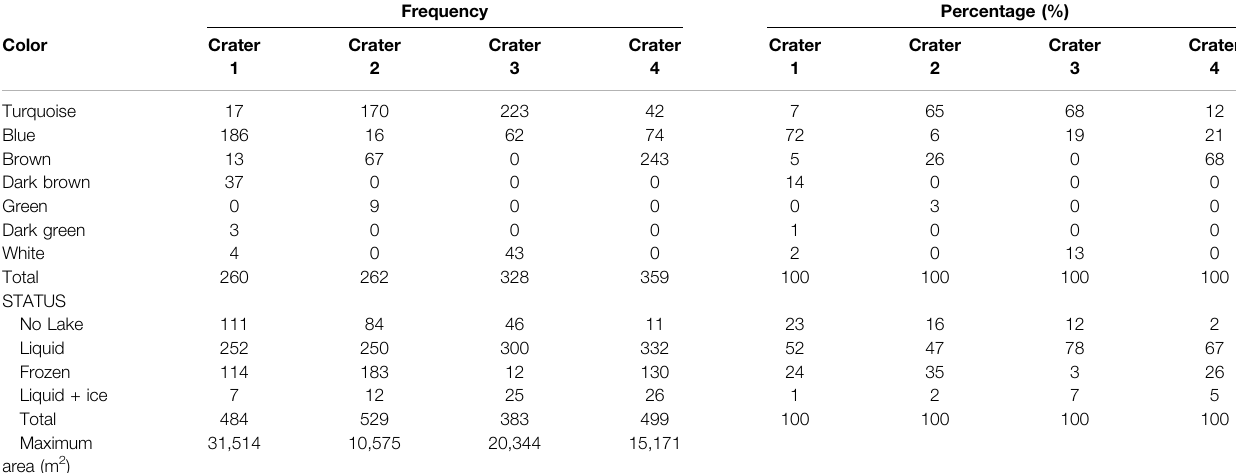
TABLE 2| ColorandstateofcraterlakesofPeteroa Volcano. Thefrequencyand percentage (%)ofcolorand state ofthelakeisindicated. Maximum area(m 2 )ofthelakesis also